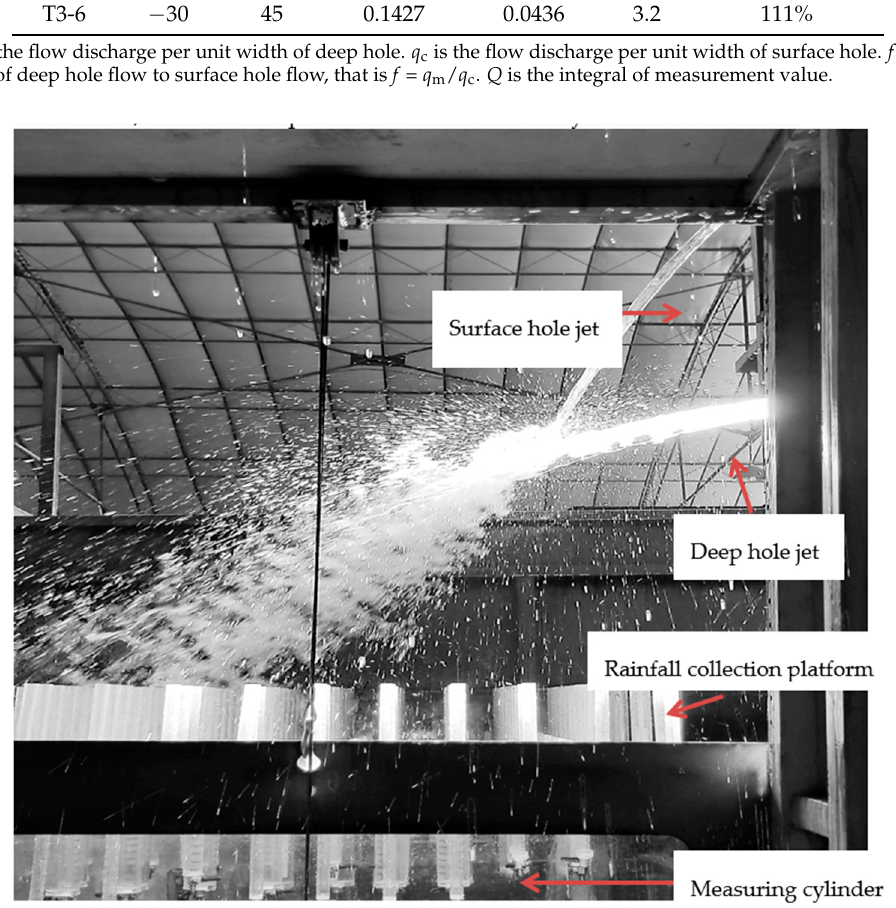
Figure 3. Rainfall collection platform in 2017.